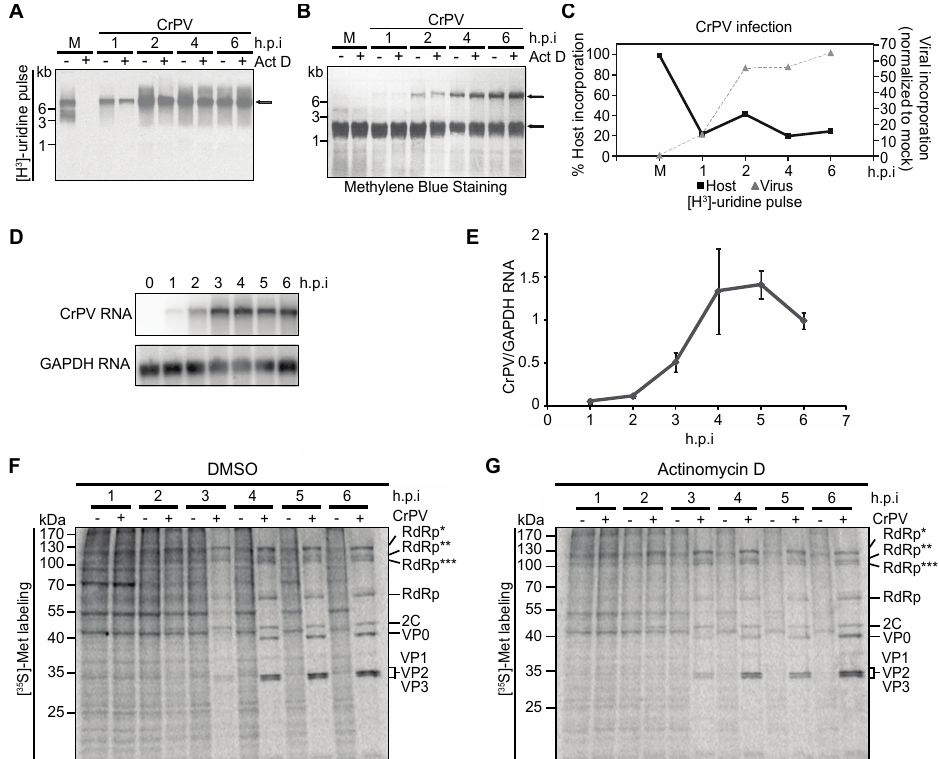
Figure 4. ( A ) Mock- and CrPV-infected S2 cells were pulse-labelled with [ 3 H]-uridine for ten minutes at the indicated hours post infection (h.p.i.) before harvesting. Where indicated, the cells were left untreated or treated with actinomycin D (Act D, 5 µg/mL) for fifteen minutes prior to pulse-labeling. RNA was extracted, loaded on a denaturing agarose gel, transferred to a nylon membrane, and analyzed by phosphorimager analysis. Representative autoradiogram and a corresponding methylene blue stain are shown in ( A , B ), respectively; ( C ) Quantitation of host and viral transcription rates in CrPV-infected cells. The rate of host transcription at each time point was calculated using the formula [(Total radioactivity in lane − Act D) − (Total radioactivity in lane + Act D)] / (Total radioactivity in lane − Act D). The rate of host transcription was normalized to that in mock-infected cells given as 100%. The rate of viral transcription was calculated at each h.p.i. by using the formula [(Total radioactivity in lane + Act D) / (Total radioactivity in lane – Act D)]. The rate of viral transcription was normalized to that in mock-infected cells given as 0%. Shown are representative gels and averages from at least 2 independent experiments; ( D ) Viral RNA levels were detected by Northern blot analysis; ( E ) Viral RNA levels were quantified using ImageQuant and plotted to show levels of viral RNA/GAPDH RNA at different time points post infection; ( F , G ) Autoradiography of pulse-labelled protein lysates resolved on a 12% SDS-PAGE gel from S2 cells mock- or CrPV-infected (MOI 10) and treated with DMSO ( F ) or 50 nM Act D ( G ) three hours prior to infection. RdRp*, RdRp**, and RdRp*** denote polyproteins containing RdRp at the approximate sizes of 120 kDa, 105 kDa, and 100 kDa, respectively. Averages are shown from at least three independent experiments (±s.d.).